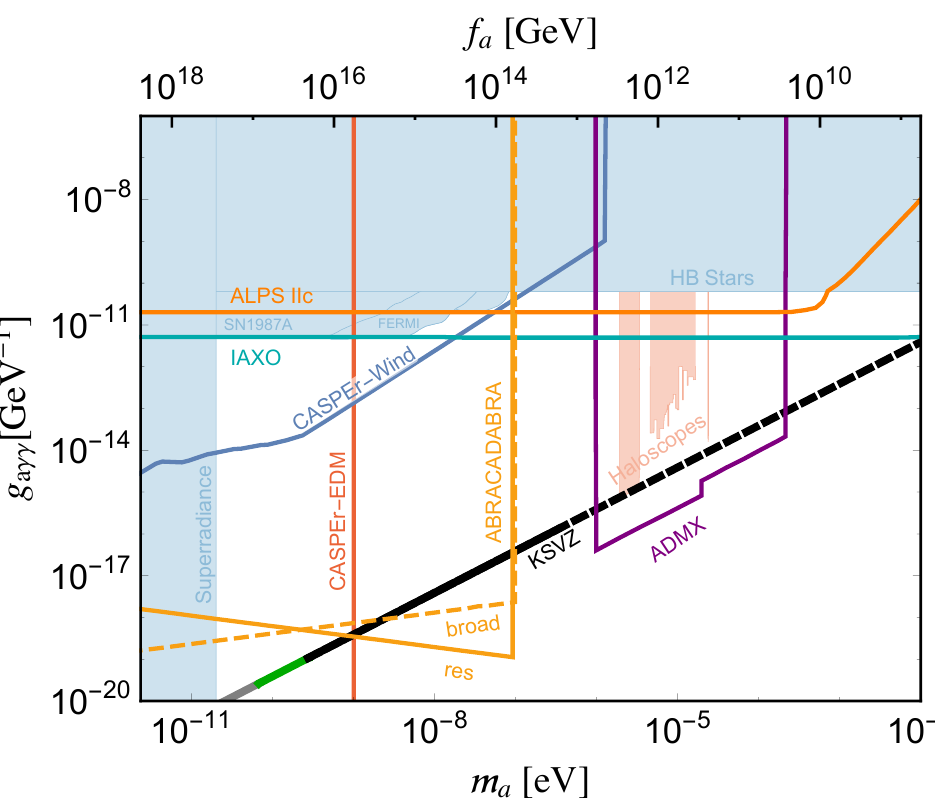
Figure 1 . Current bounds and future experimental reach for axion couplings to photons de(cid:12)ned in eq. (2.1). Blue shaded regions show the current constraints which are independent of a dark matter interpretation, while the red shaded region are constraints from axion haloscopes. Sensitivity of future experiments is shown by colored lines. The thick black line shows the prediction for the KSVZ axion as in eq. (2.2). The solid part of the line indicates where the initial misalignment would need to be tuned (cid:18) i < 0 : 1 or worse, which is where our mechanism is needed to have the correct axion abundance. For larger values of f a (the green part of the line) the extra dark radiation produced by our mechanism will be within the sensitivity of future CMB experiments. Even larger f a values (the gray part), are already constrained by Planck observations (see discussion in section